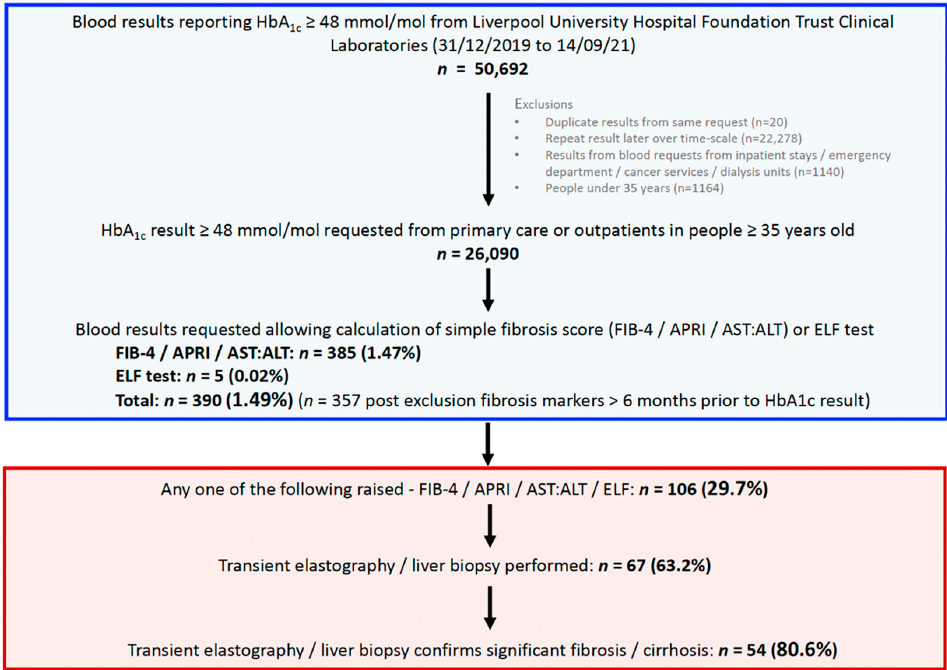
Figure 1. Study flow chart and summary of results. HbA 1c , glycated haemoglobin; FIB-4, fibrosis-4; APRI, aspartate transaminase to platelet ratio index; AST aspartate transaminase; ALT, alanine transaminase; ELF, enhanced liver fibrosis